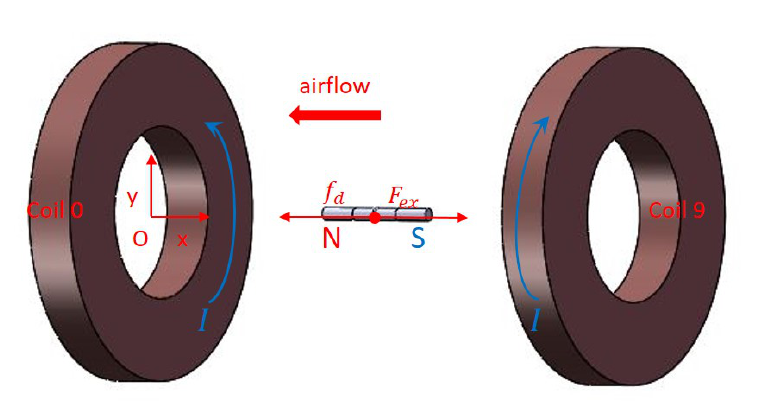
Figure 2. The x-direction coil and suspension model of the